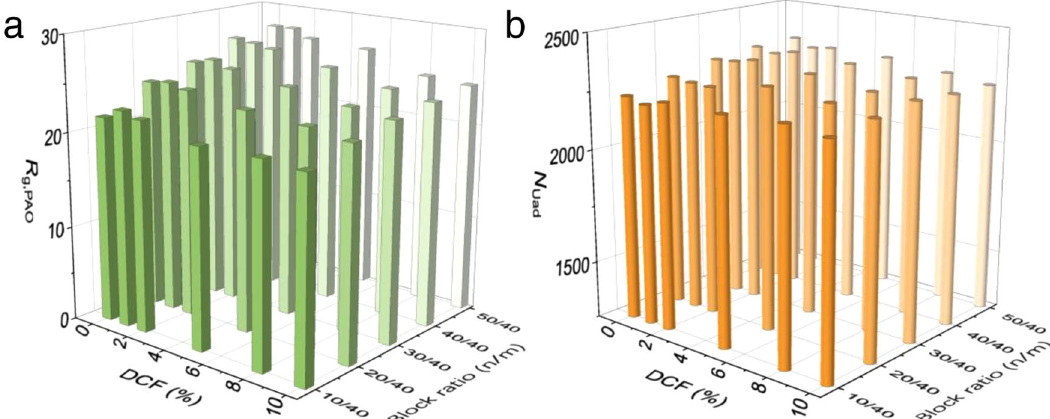
Fig. 5 Dead polymer chains evaluation. a The equilibrium R g,PAO of PAO m - b -PPEGMA n varying with different DCFs and block ratios. b The number of adsorbed U-beads ( N Uad ) b y PAO m - b -PPEGMA n varying with different DCFs and